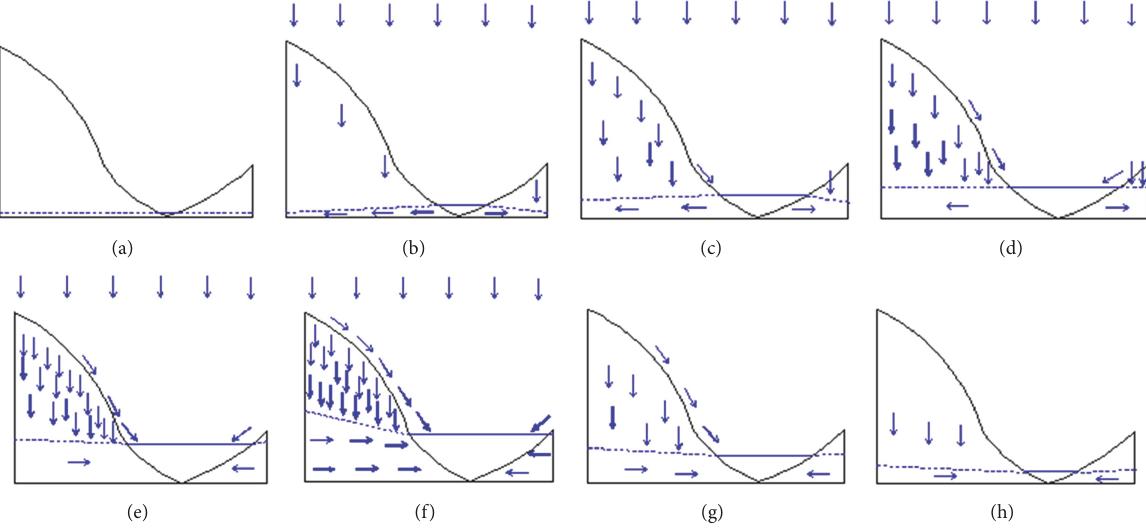
Figure 1: River-groundwater interaction under rainfall event: (a) initial state; (b) groundwater level raised by rainfall infiltration and river supply; (c) more rainfall and river supply and overland flow produced; (d) high groundwater table produced by continuous rainfall; (e) groundwater conversely supplies the river level; (f) increased groundwater accelerates the water flow supply to river; (g) overland flow and rainfall infiltration decrease; (h) recovery to the initial